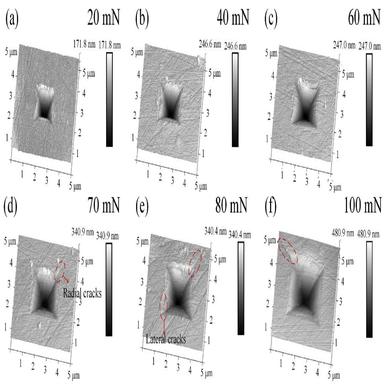
Measured indentation imprints topography with AFM for the Si matrix under different load conditions of. (a) 20 mN. (b) 40 mN. (c) 60 mN. (d) 70 mN. (e) 80 mN. (f) 100 mN.